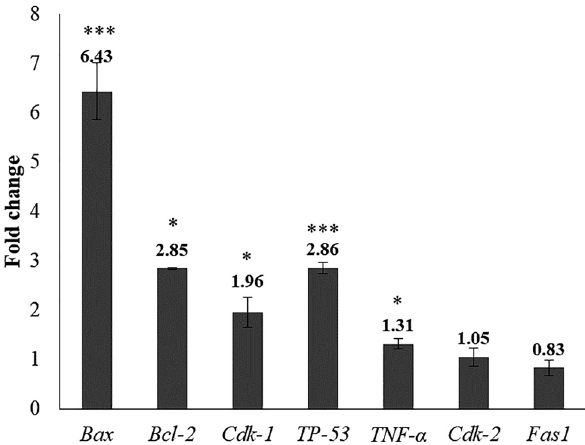
Figure2: GeneexpressionanalysesofHCT116cellstreatedwiththe ethyl acetate extract of C. hystrix . The bar chart shows the gene expression patterns (expressed as the fold change relative to the untreated control) of selected genes involved in apoptosis (with respect to GAPDH , a housekeeping gene). *p<0.05, **p<0.01, ***p<0.001.